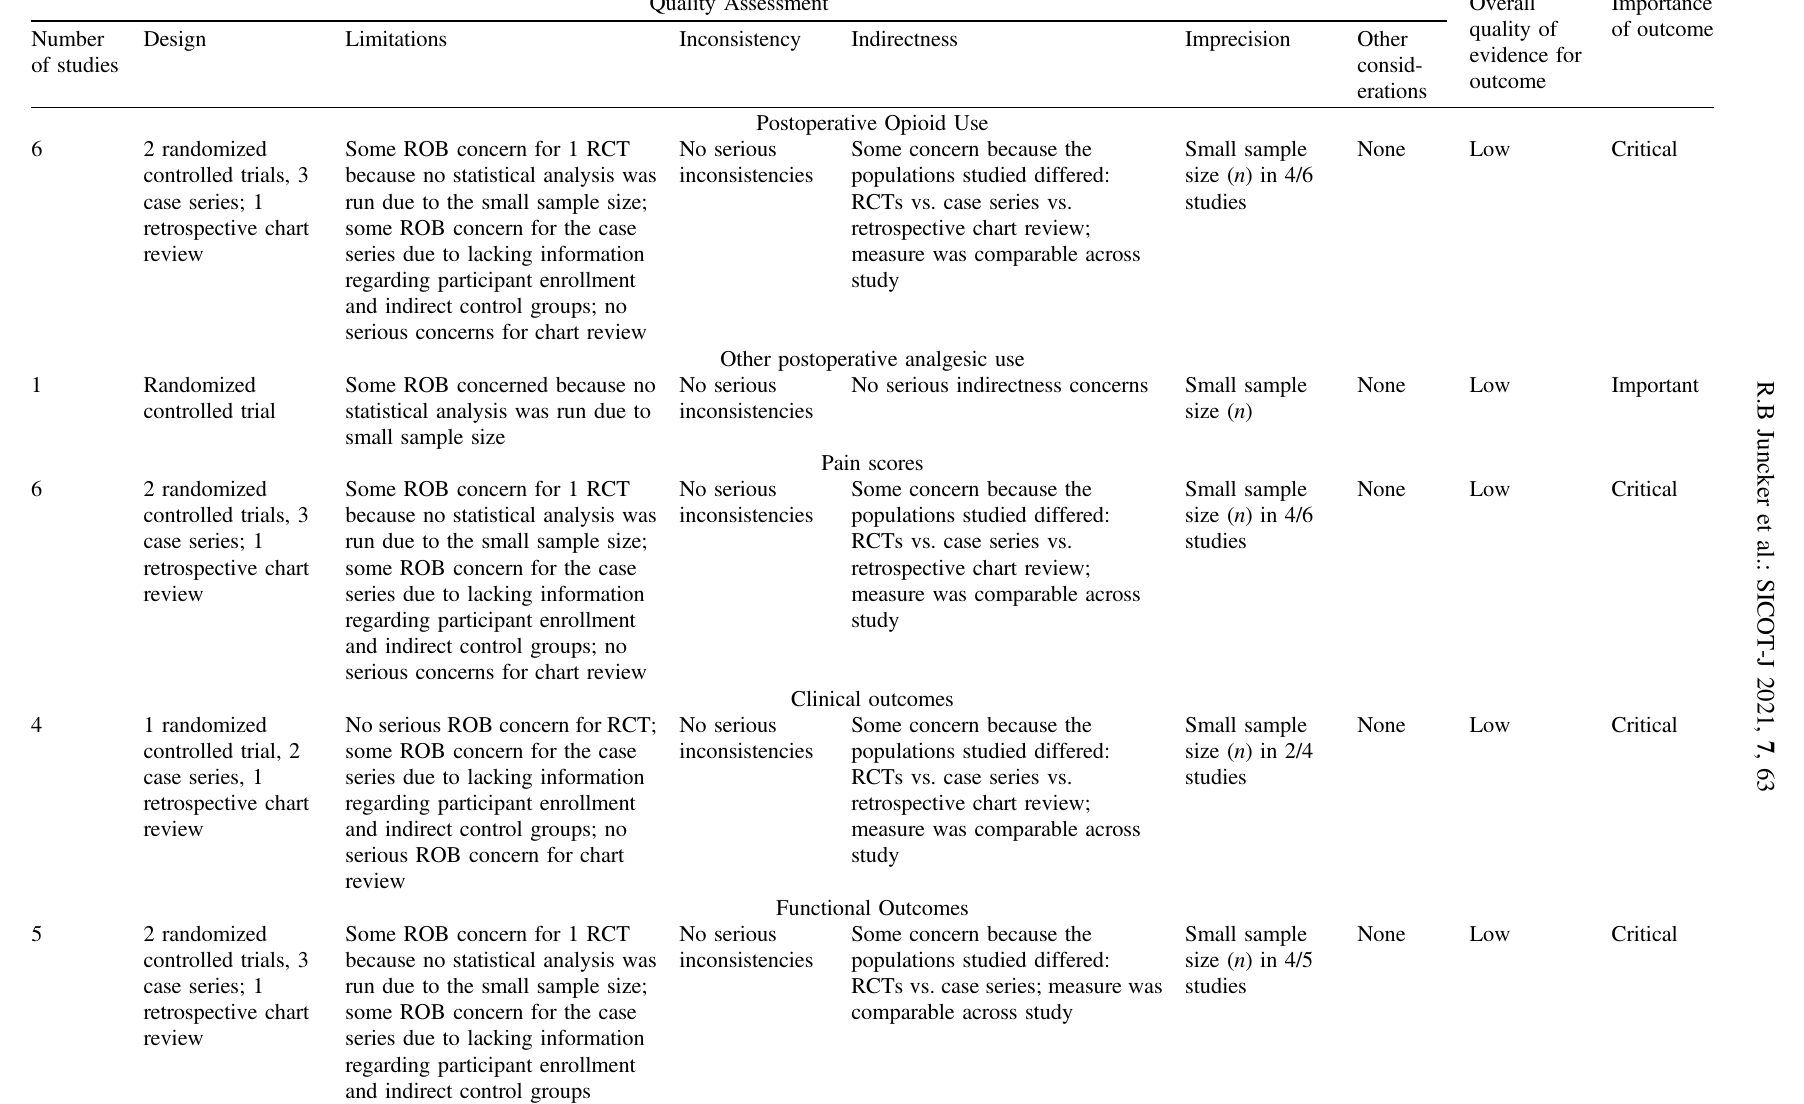
Table 5. GRADE evidence pro fi